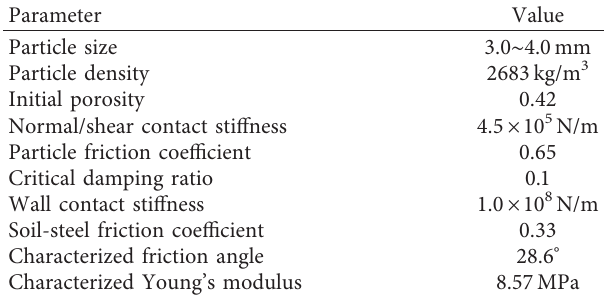
Table 1: Particle parameters used in the DEM